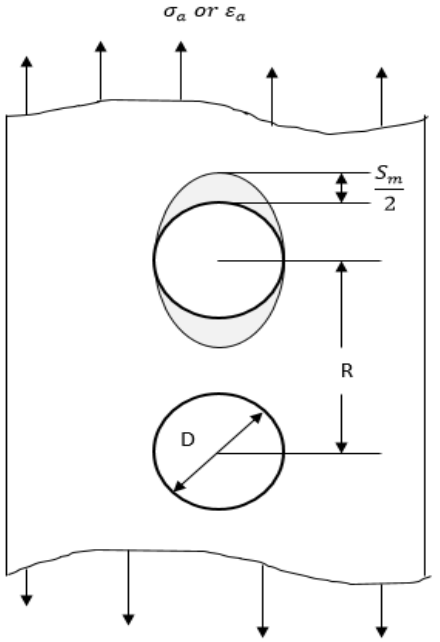
11 of 14 Figure 12. Fracture surfaces of 212 µm filler-reinforced composites under different strain rates: ( a ) 0.00028 s −1 , ( b ) 0.00085 s −1 , and ( c ) 0.0017 s −1 . 3.6. Mathematical Models for Particle–Matrix Interactions A number of micromechanical models have been developed to further support the relationship between the particle’s size and the dispersion effect on composites. Studies have been conducted on stress distribution using finite element analysis [27,28] and analytical models [25]. According to past